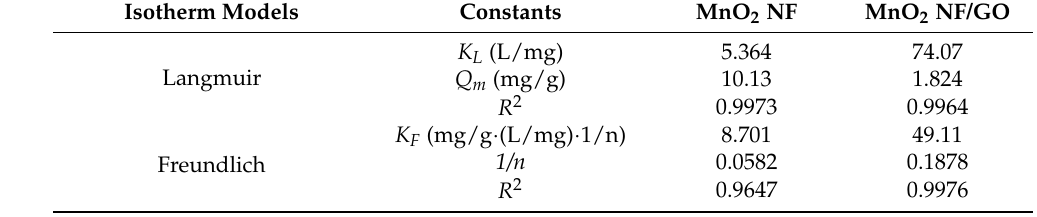
Table 3. Langmuir and Freundlich constants related to the adsorption isotherms of BbFA for as- synthesized composites.